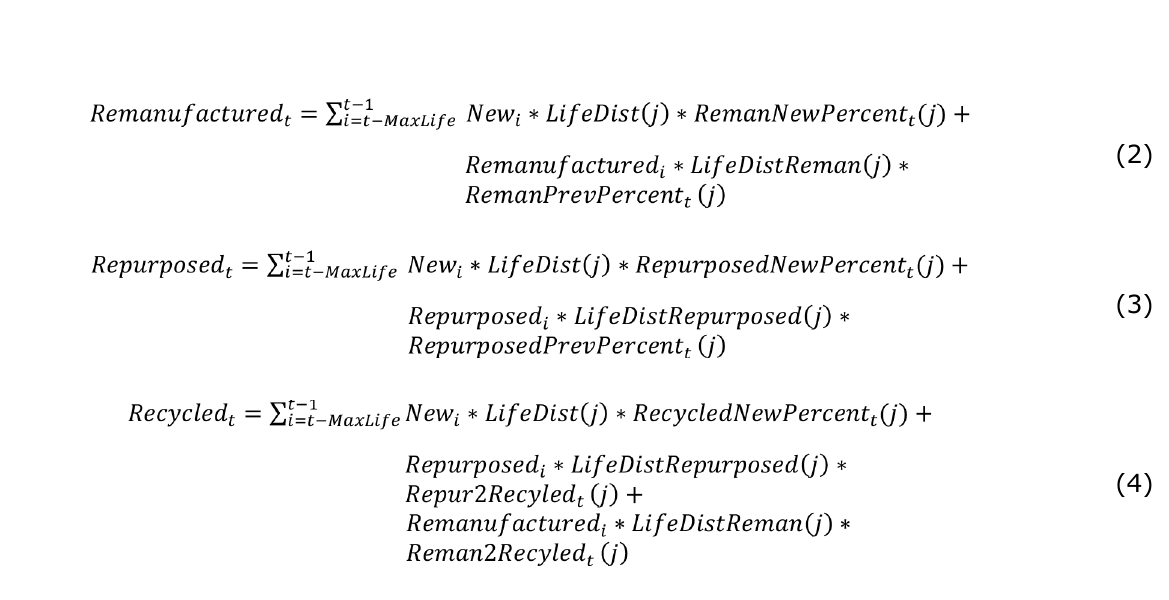
Table 1. Capacity Planning Model